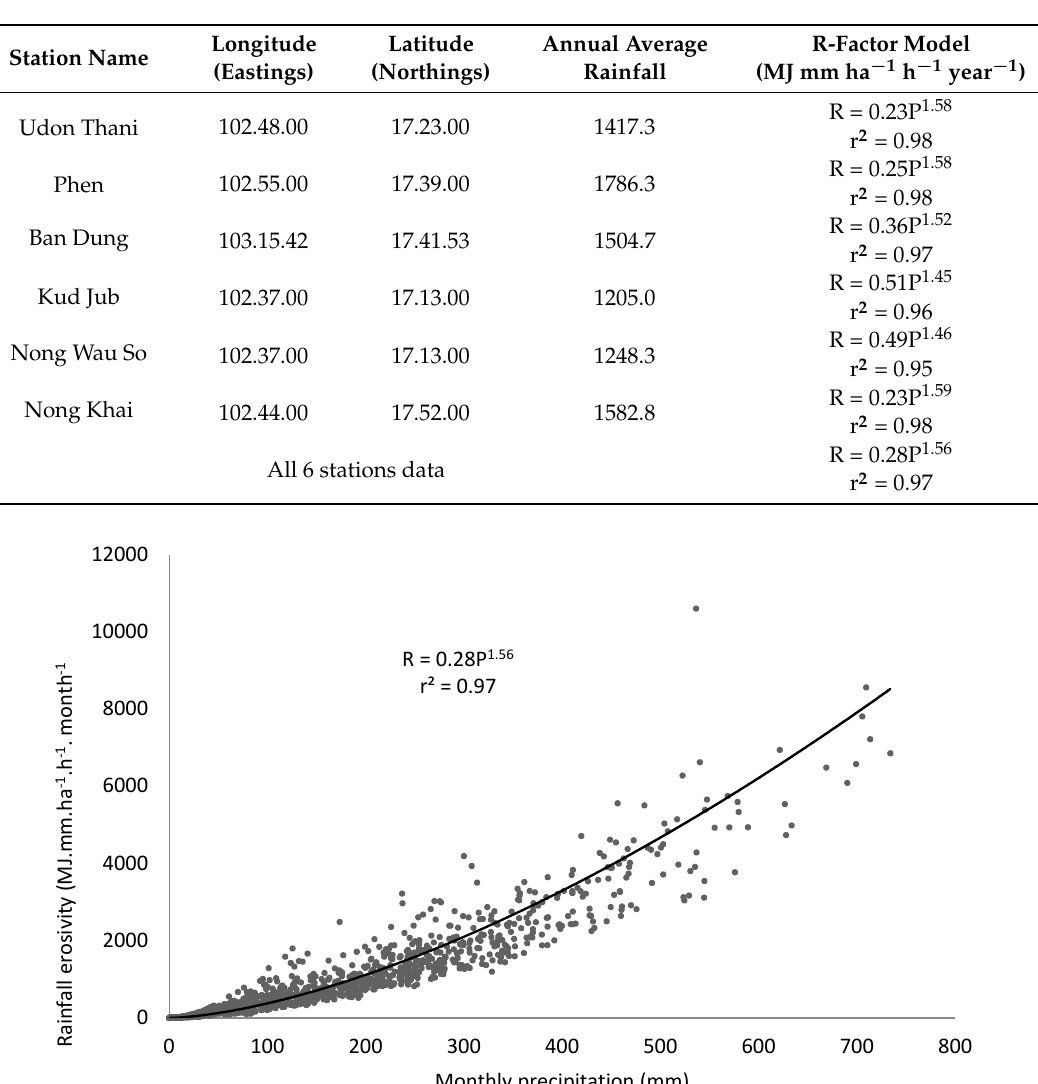
Table 4. The developed R predictive models based on observed rainfall (1982–2005).